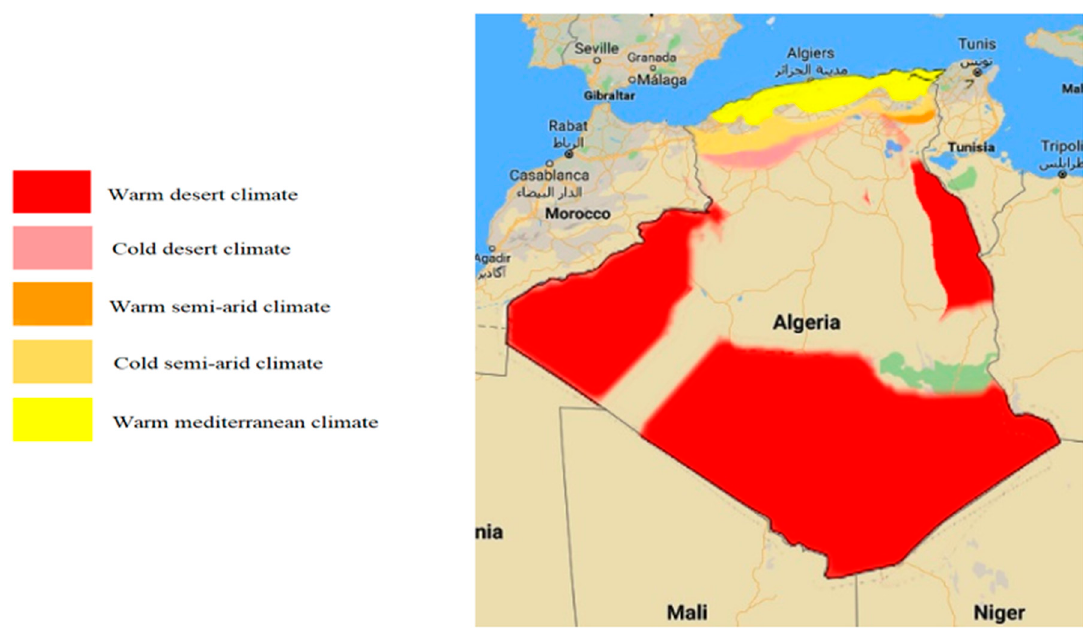
Figure 8. The temperature distribution in Algeria.